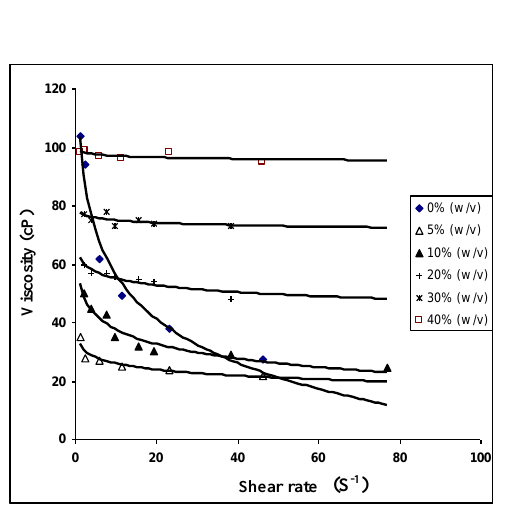
Figure(6): Effect of sorbitol concentration on the viscosity of 2.0% (w/v) pectin sols loaded with 2.5% (w/v) naproxen at 25 ºC.